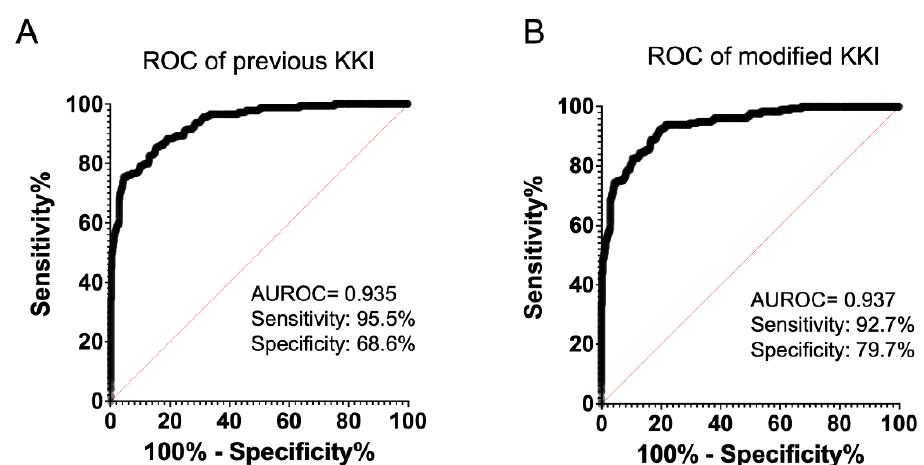
Figure 1. ROC curve analysis delineating the sensitivity and specificity of keratoconus screenings using an autokeratometer. ROC curves for each diagnostic parameter are shown for the KKI and modified KKI equation ( A , B ). AUROC, area under the ROC curve; KKI, keratometer keratoconus index; WTR, with-the-rule; CI, confidence interval.